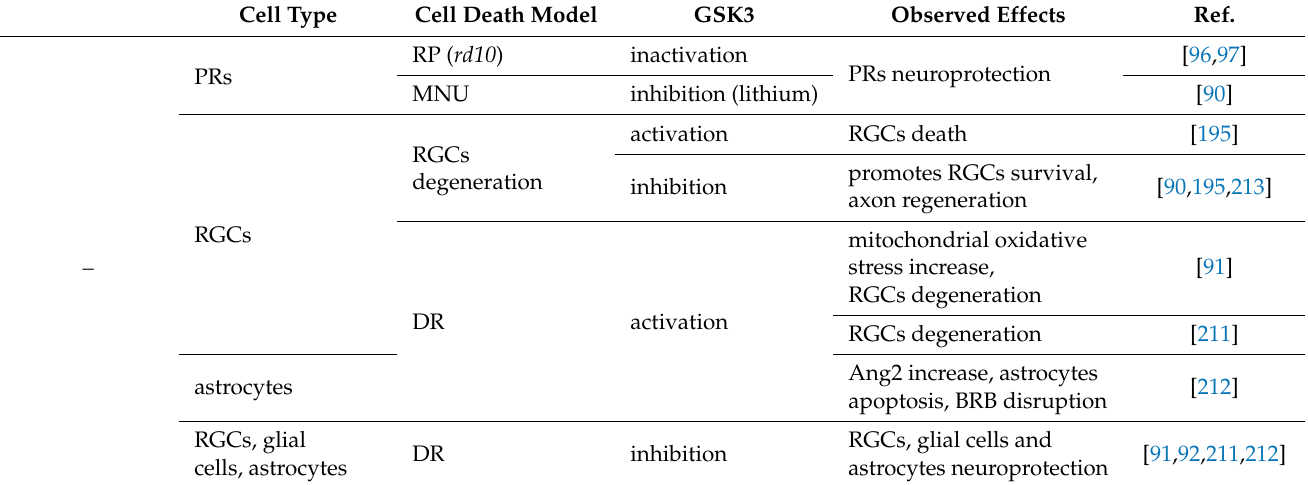
Table 1. Overview of GSK3-putative or -demonstrated role under different retinal